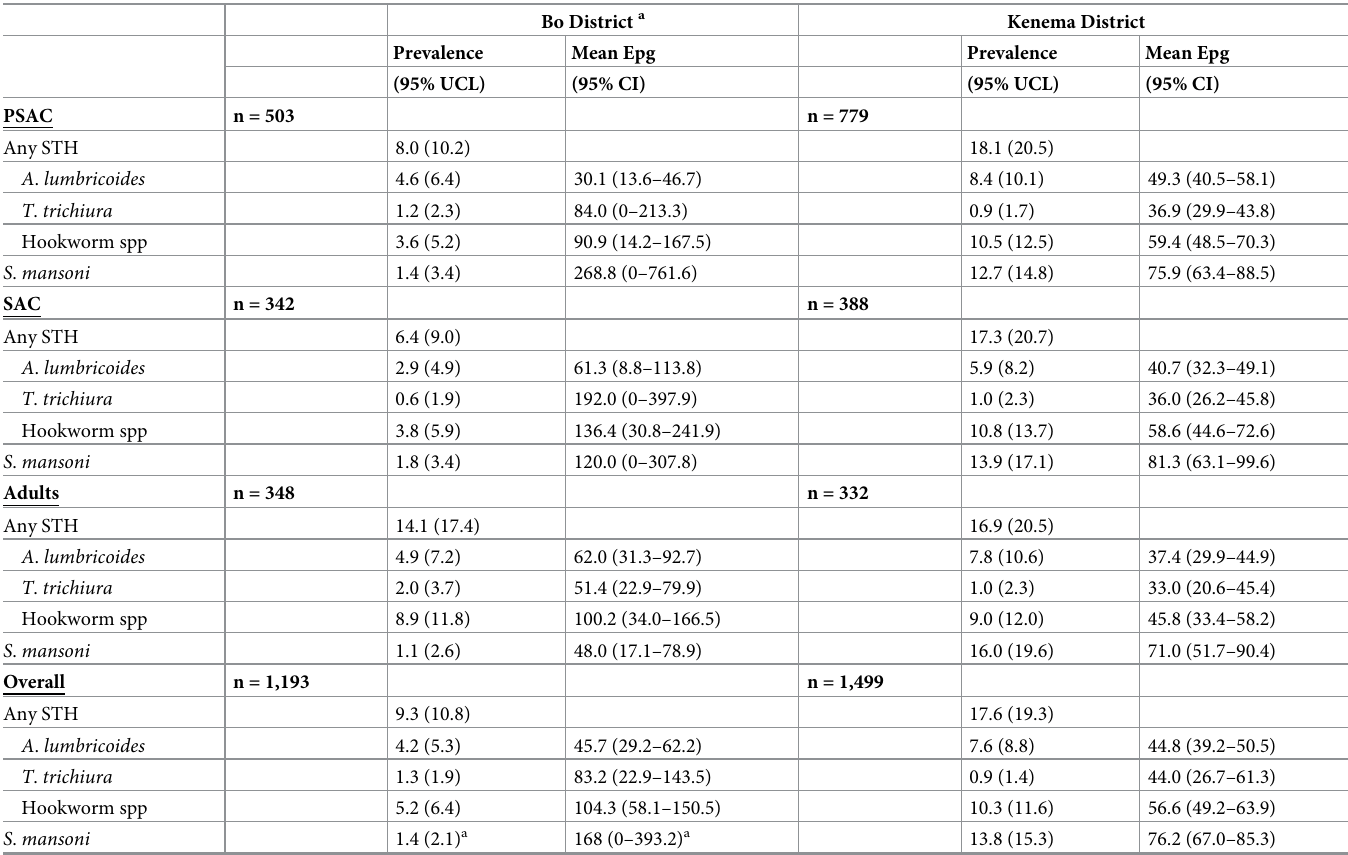
Table 2. Prevalence of infection for all species by age group and